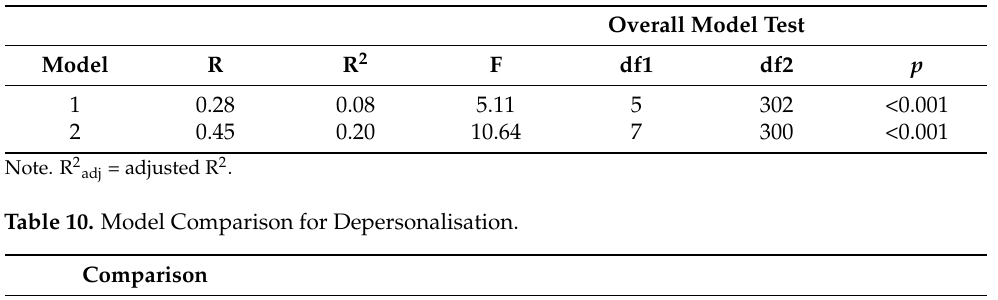
Table 9. Overall Model Test for Personal Fullfillment.